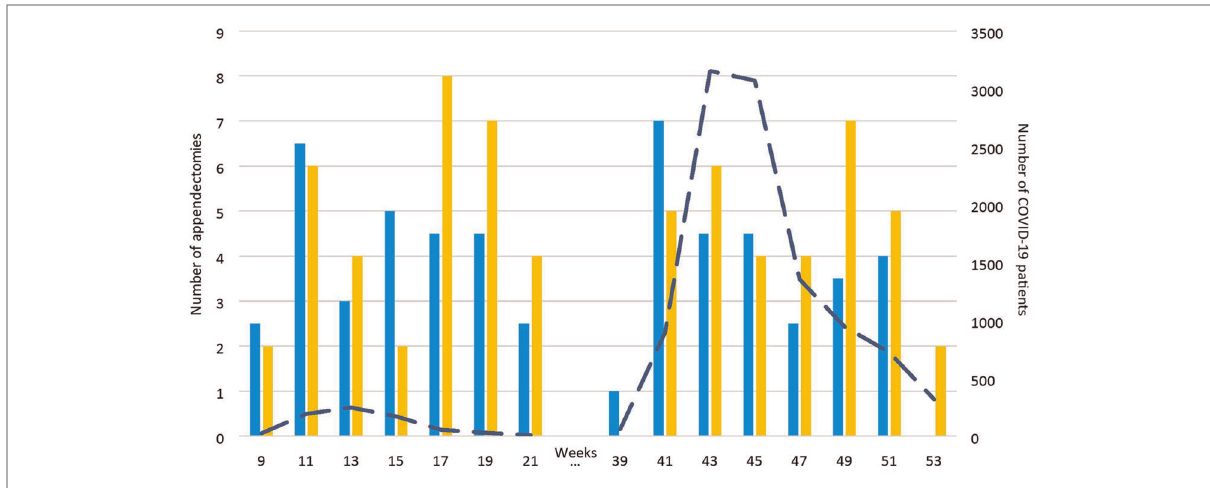
FIGURE 2 Number of appendectomies in 2018/2019 and 2020 (columns) as compared with the number of COVID-19 patients in 2020 (dotted line).